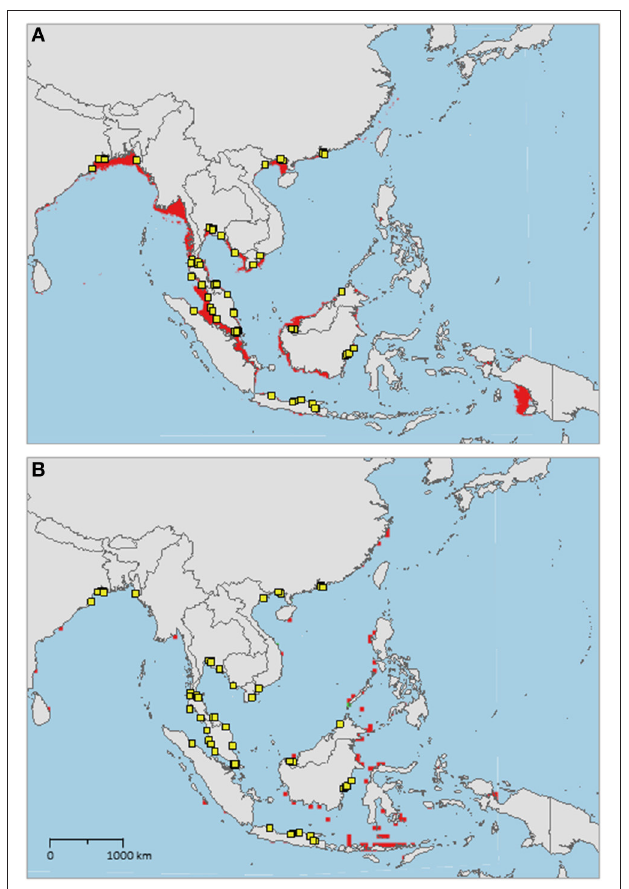
FIGURE 4 | Distribution maps for Tachypleus gigas with environmentally unique points, indicating the sampled distribution range for the species. Upper map (A) shows present-day projections of suitable habitat in red based on consensus of Maxent and SVM algorithms. Lower map (B) show changes between the present-day and 2050 projections of suitable habitat based of consensus of Maxent and SVM algorithms, with green cells indicating loss of suitable habitat and red cells indicating gain of suitable habitat. Support values for the individual models are given in Table 3 .